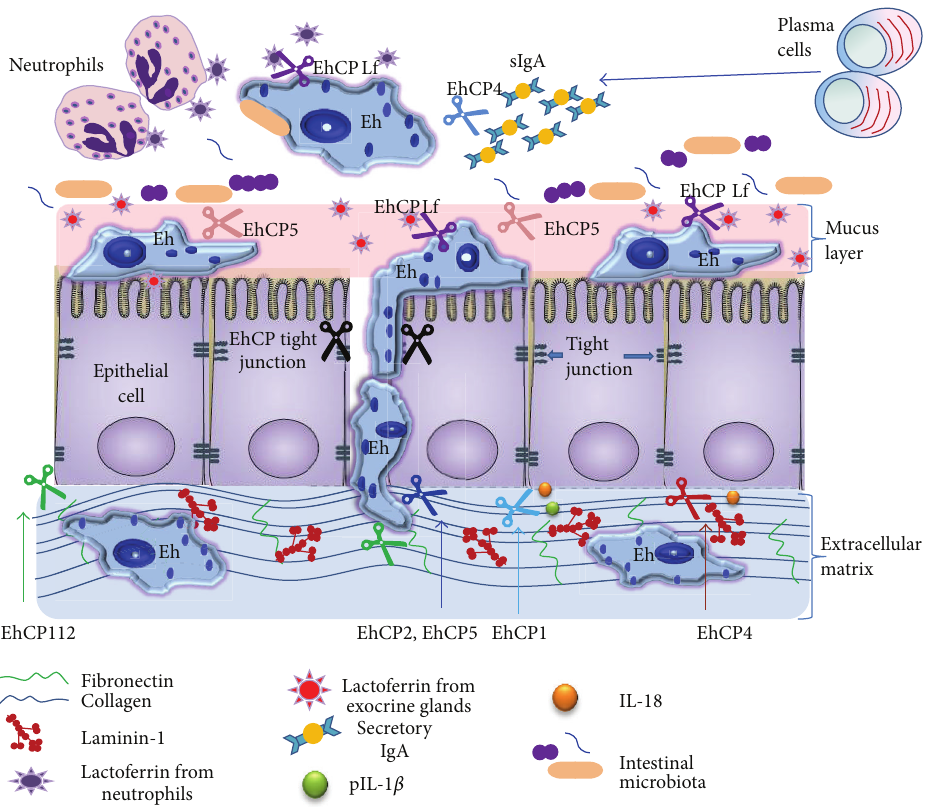
Figure 1: Proteases from E. histolytica as virulence factors during intestinal